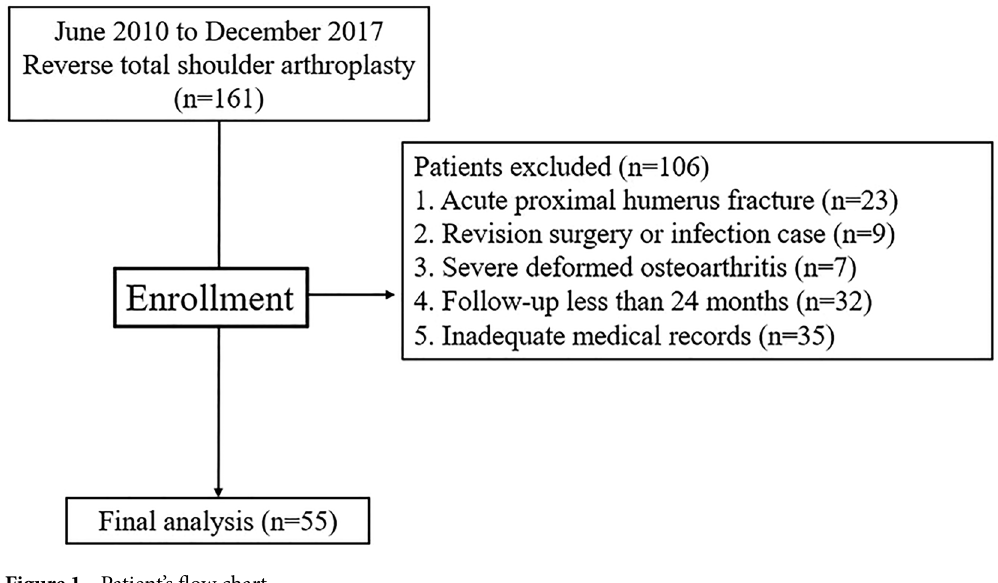
Figure 1. Patient’s flow